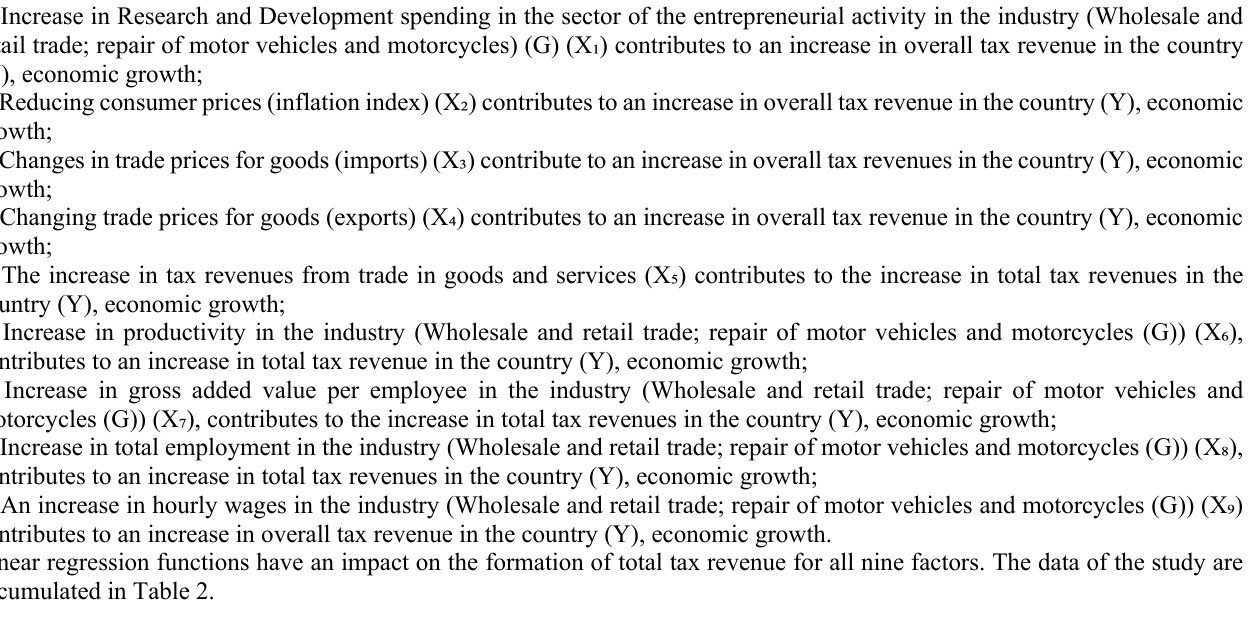
Initial visualization of the results of resolving hypothetical claims about the existing relationship between performance and impact indicators